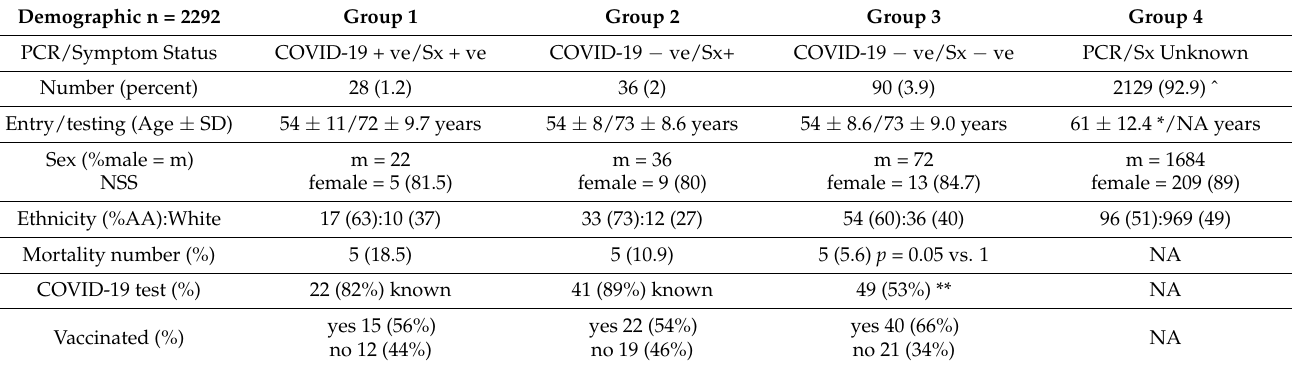
Table 1. Demographics and hospitalization data in COVID-19 and control groups.